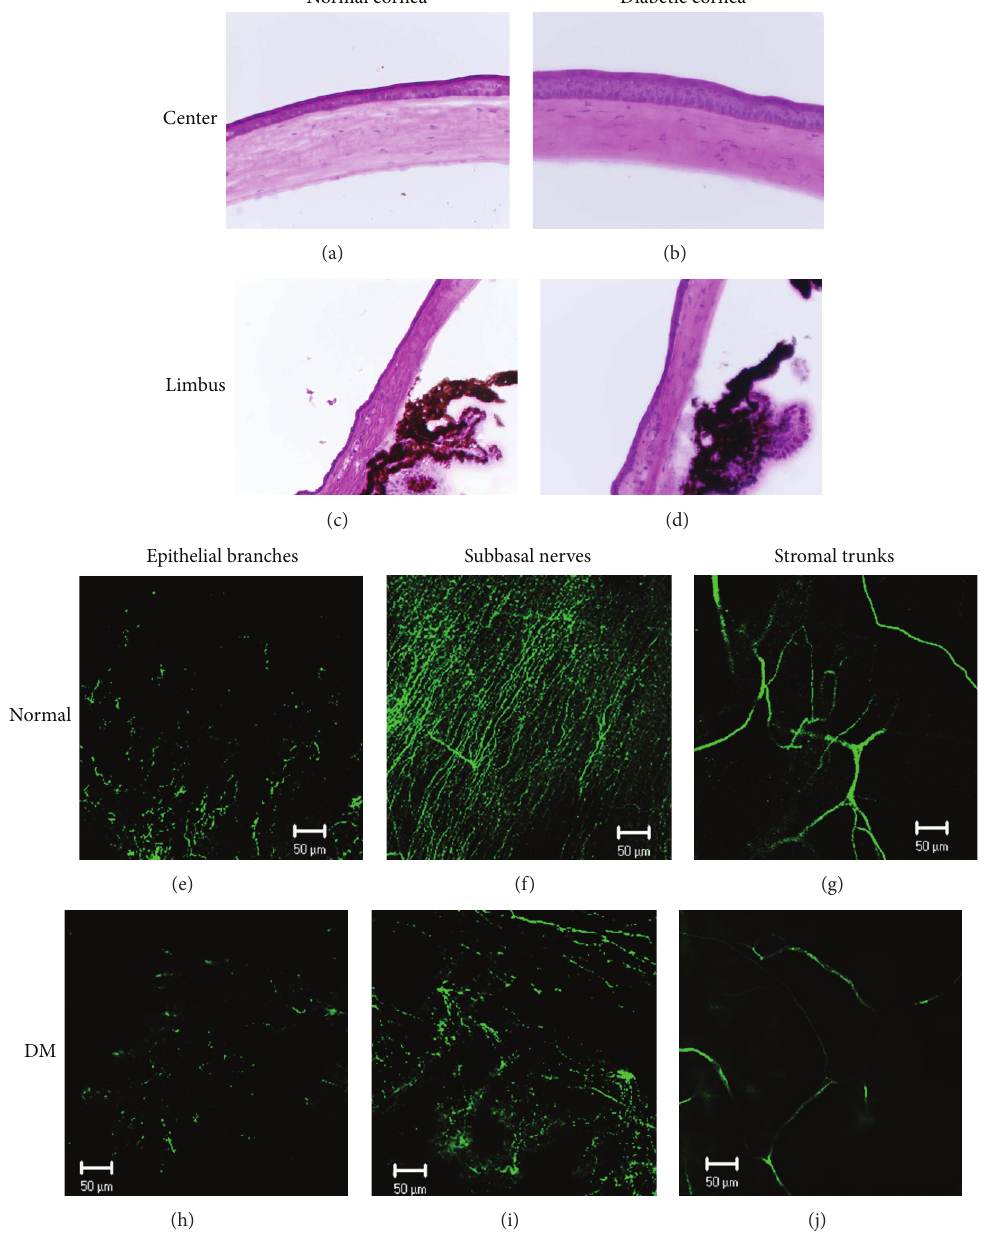
Figure 1: Ocular properties in ob/ob mice. Representative histological photomicrographs of hematoxylin and eosin-stained globe sections that were obtained from normal and 12-week-old diabetic mice. Swelling and stratification of the diabetic corneal epithelium are noted in comparison with the normal cornea. Magnification: 200x. Representative biomicroscopy of a normal cornea ((a) and (c)) and of a diabetic mouse cornea after 12 weeks ((b) and (d)). Representative histological photomicrographs of corneal nerves that were immunostained with an anti- 𝛽 -III-tubulin fluorescein isothiocyanate-conjugated antibody showing the epithelial nerve (left column), subbasal nerve plexus (middle column), and stromal nerves (right column) in the normal eye ((e), (f), and (g)) and in a 12-week-old diabetic mouse eye ((h), (i), and (j)). Note the development of marked nerve degeneration after 12 weeks when the nerves appear faint and interrupted. Magnification: